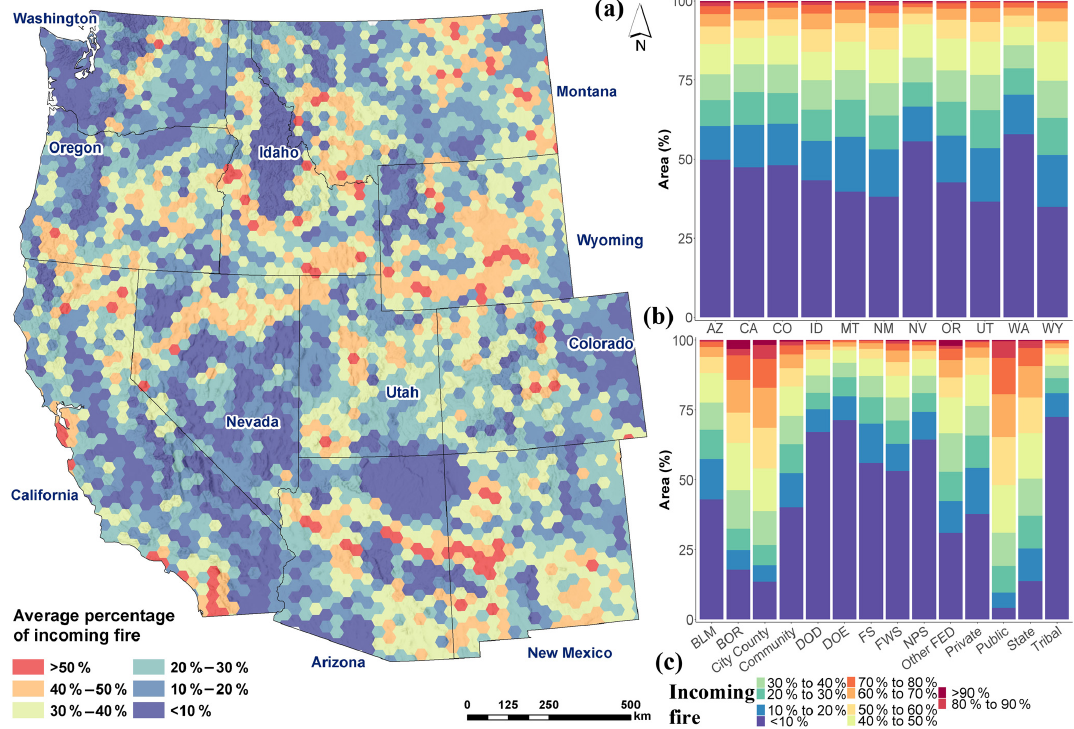
Figure 4. (a) Average percentage of incoming fire across the western US; (b) by state, calculated for its entire area and for all land tenures; (c) by land tenure, across all 11 western US